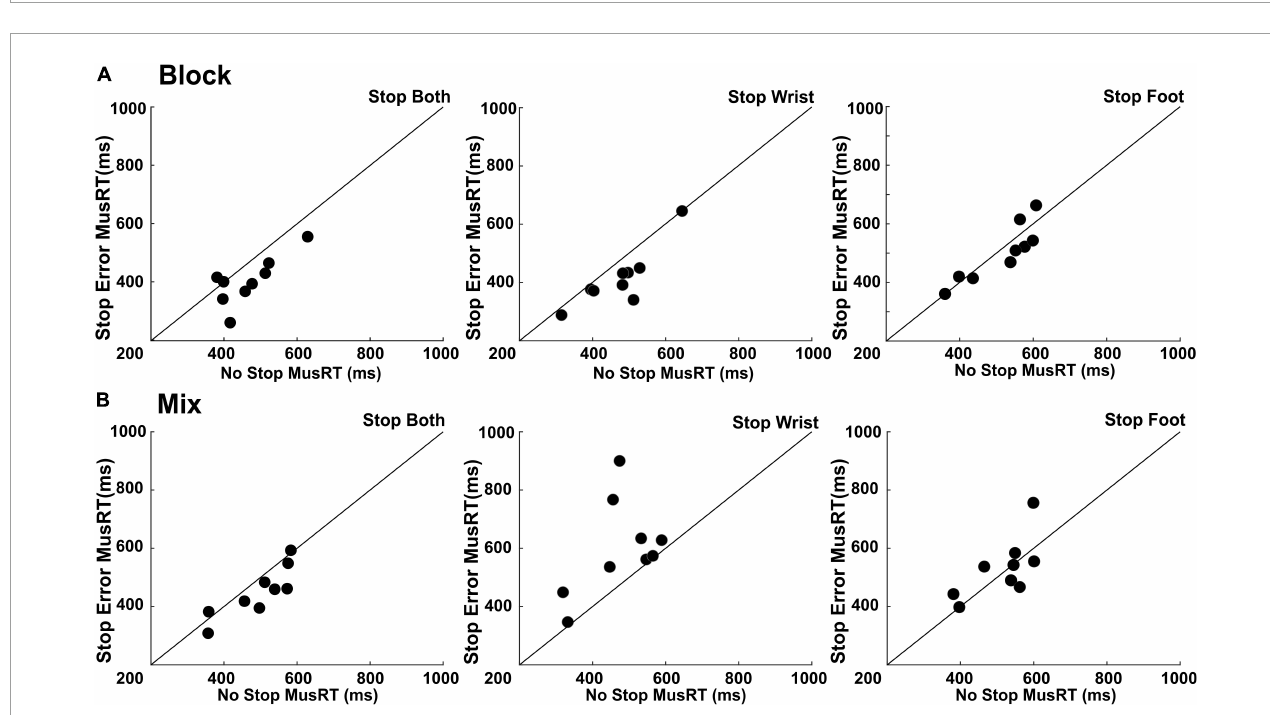
FIGURE4 Test of independence assumption. Scatter plots of Stop Error MusRTs respect that of No Stop trials in the different selective stop conditions presented in Block (A) and Mix (B) design. Each dot represents a participant. Equality line is also depicted.